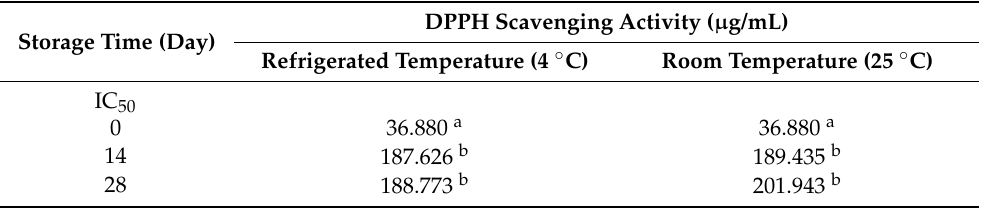
Table 5. The scavenging ability of DPPH radicals of Lactobacillus fermentum InaCC B1295 in CMFH- OPEFB at different temperatures for 28 days of